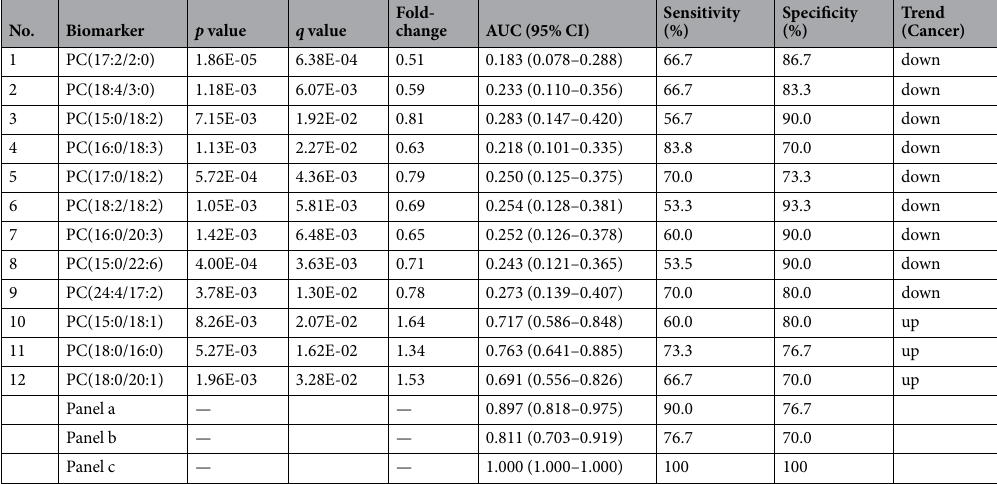
Table 6. Detection of PCs as potential biomarkers for the diagnosis of early-stage NSCLC. Panel (a): combination of down-regulated PCs; Panel b: combination of up-regulated PCs. Panel (c): combination of 12 altered